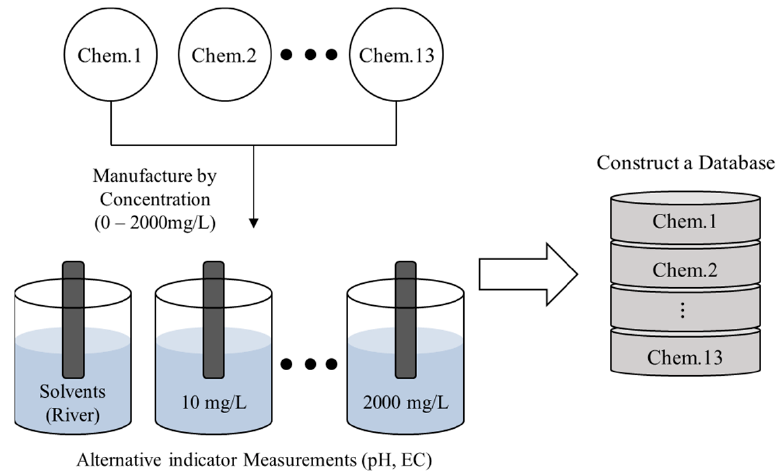
Figure 1. Schematic diagram of chemical (Chem.) database construction for pH and electrical conductivity (EC) measurements.